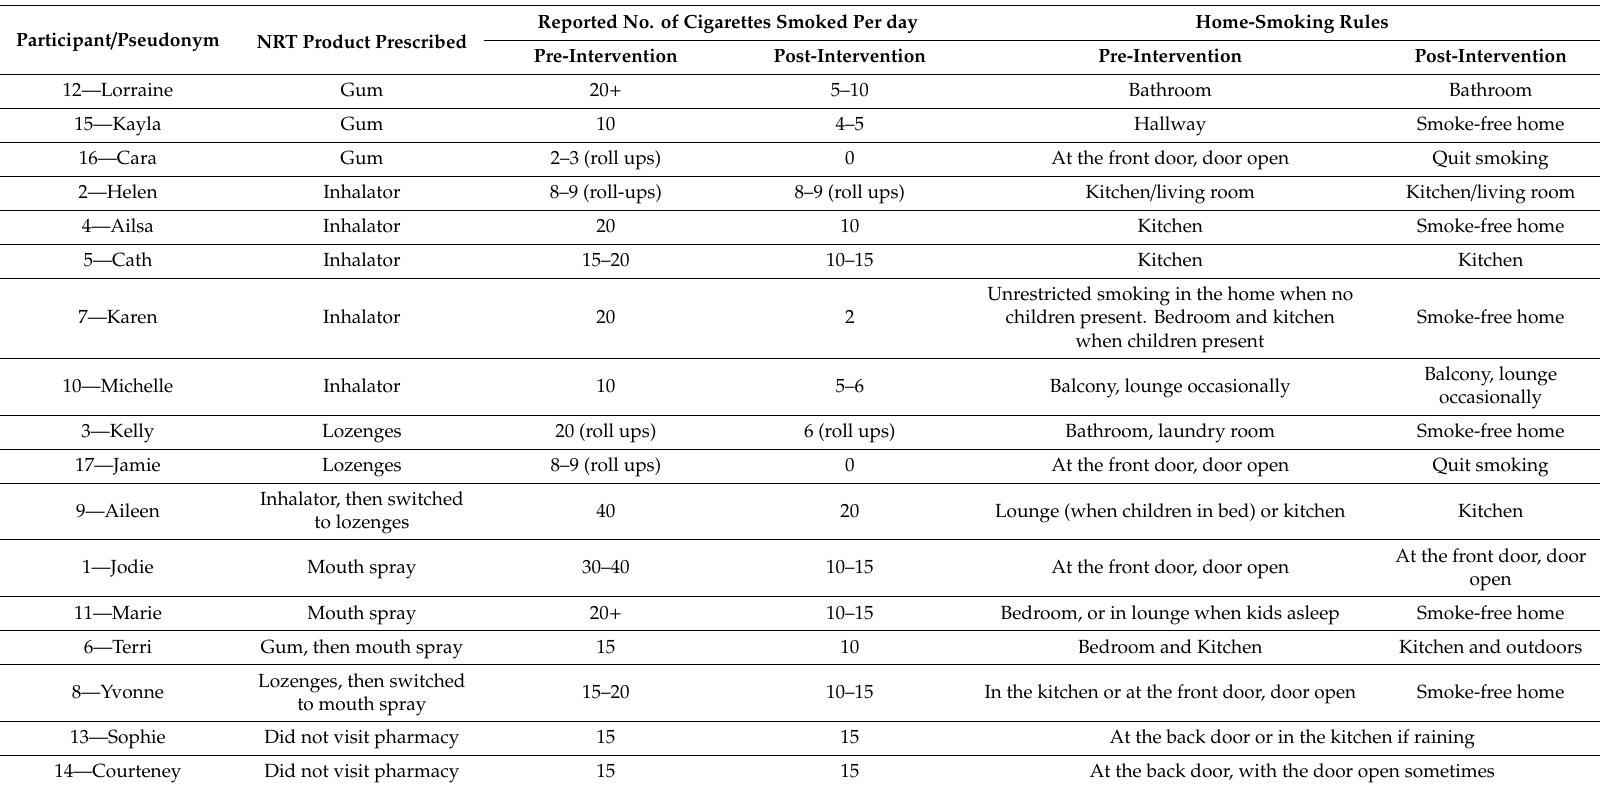
Table 1. Nicotine replacement therapy (NRT) uptake and home-smoking rules pre and post 12 week NRT